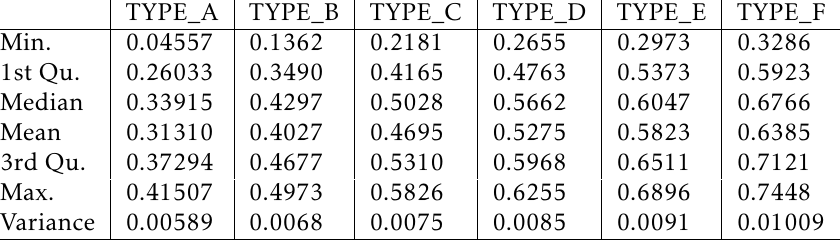
Table 4. Noise Density with respect to first order change in entropy